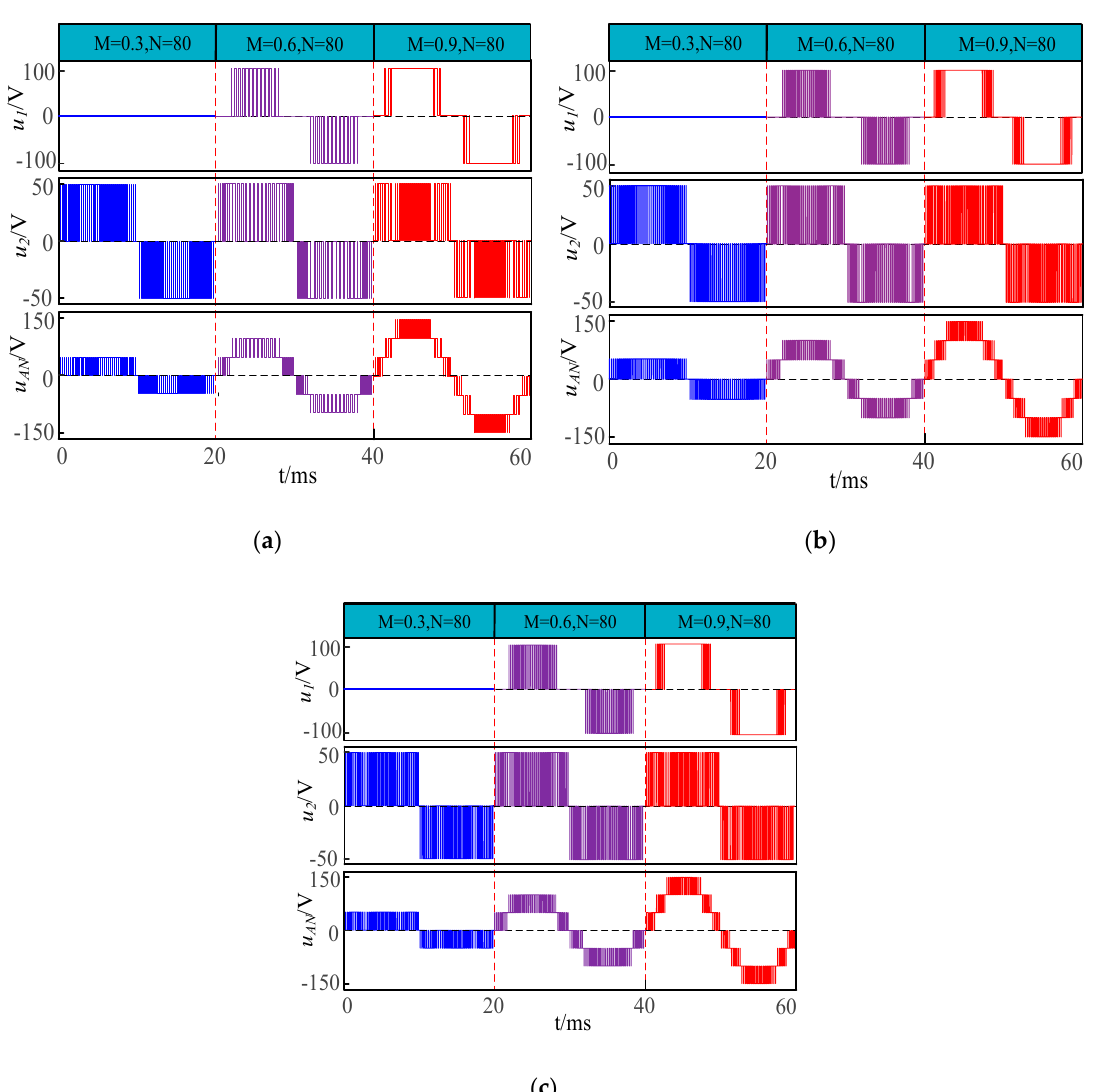
Figure 10. Voltage output charts under three modulation strategies. ( a ) Output characteristics under mixed frequency modulation strategy. ( b ) Output characteristics under unipolar LS-PWM modulation strategy. ( c ) Output characteristics of double frequency modulation strategy based on LS-PWM.